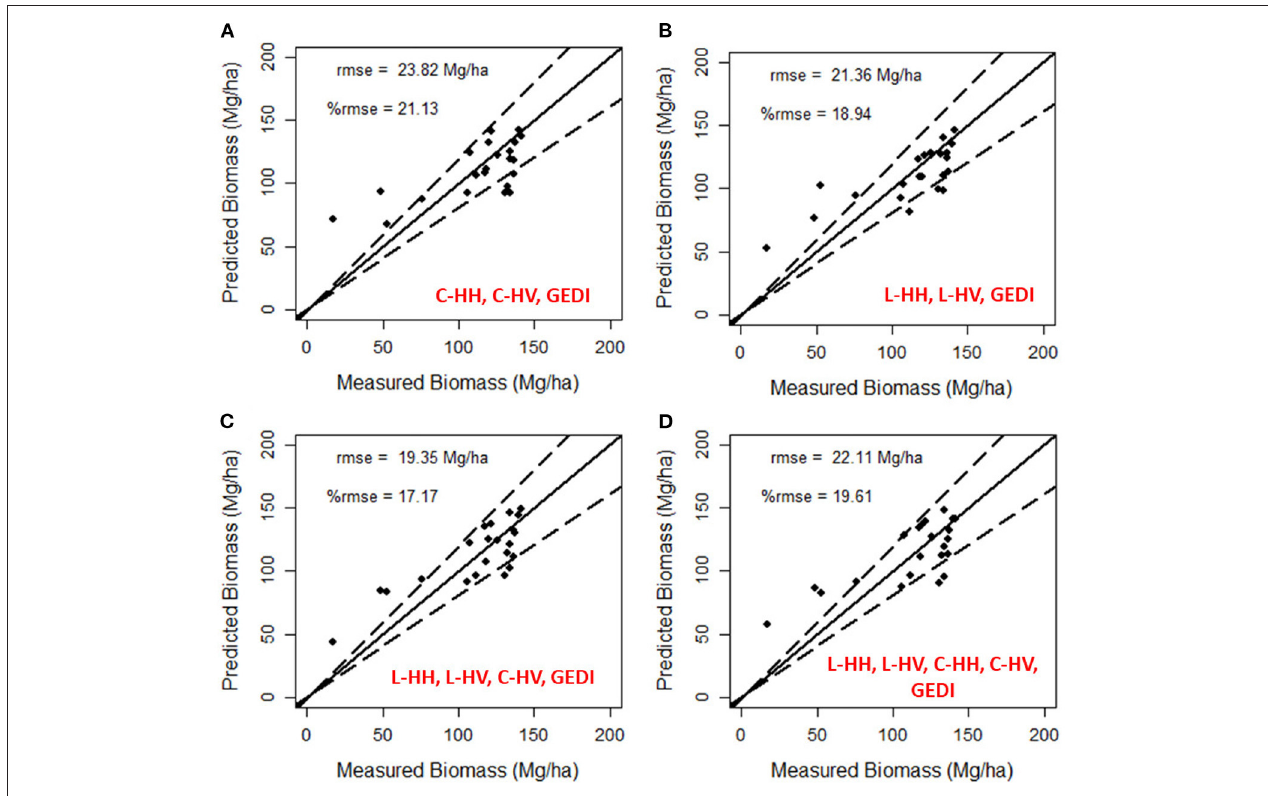
FIGURE 7 | Validation of modeled AGB using multi-frequency SAR data and interpolated LiDAR canopy height data. The model performance of different combinations is shown in (A) L-band SAR data and LiDAR, (B) C-band SAR data and LiDAR, and (C,D) showing the combination of C- and L-band SAR with LiDAR data. The dotted lines show a 20% error